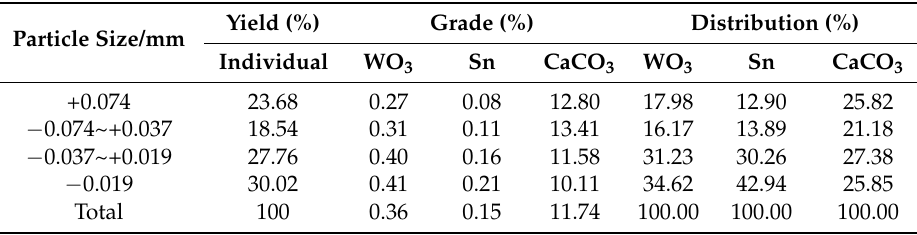
Table 1. Particle analysis of the raw ores.